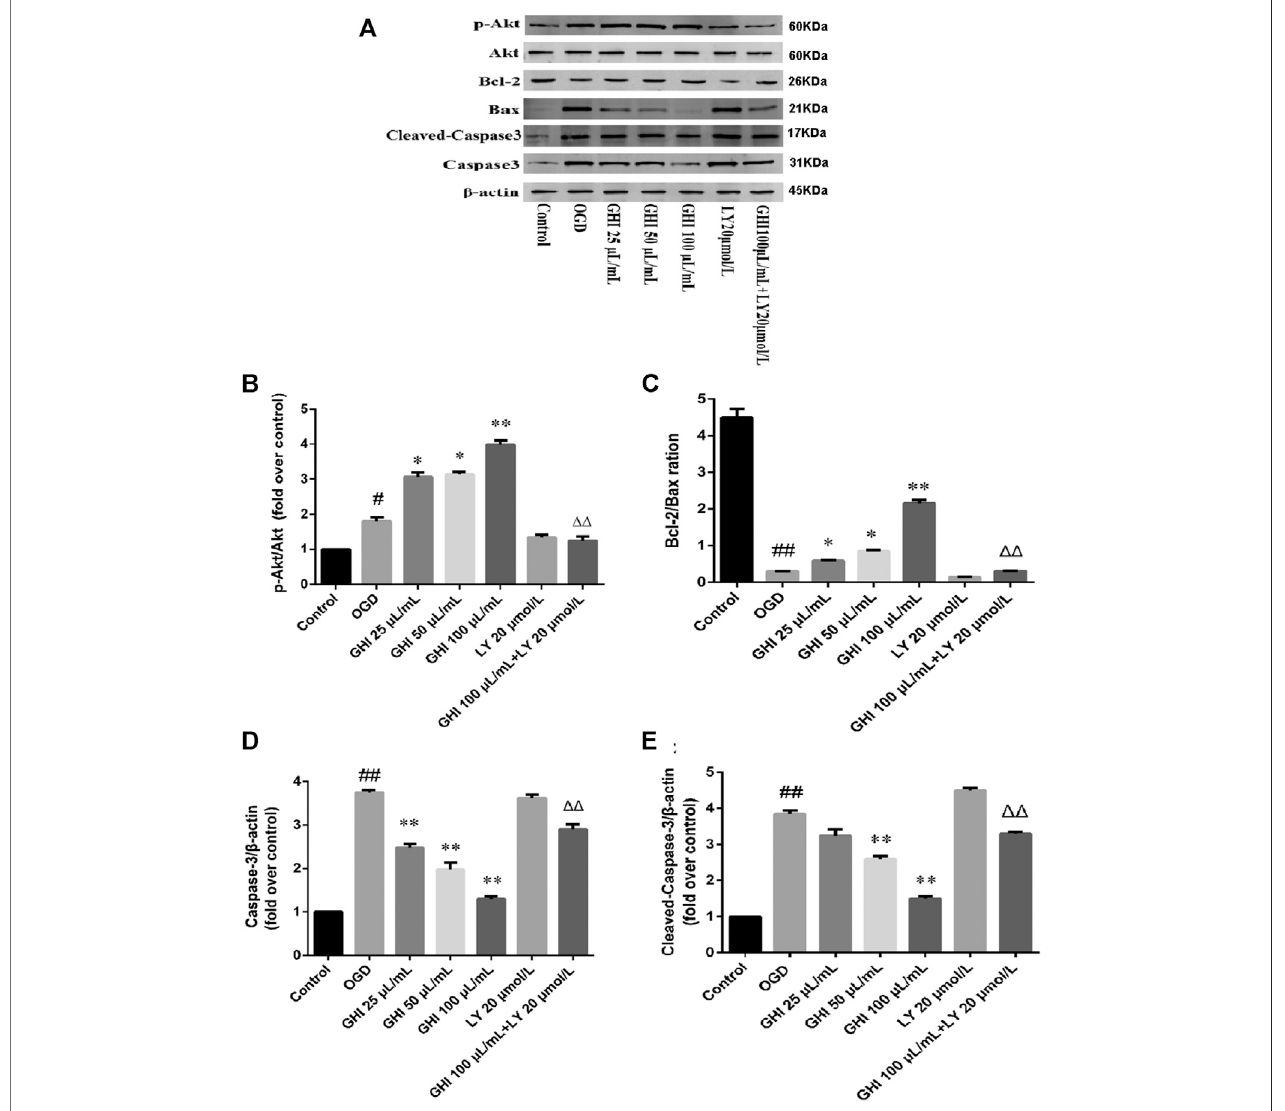
FIGURE15| GHIattenuatedOGD-inducedinjurybyregulatingthePI3K/Aktpathway. (A) RepresentativeimmunoblotsofAkt,p-Akt,Bax,Bcl-2,cleavedcaspase- 3,andcaspase-3proteins. (B) Theratioofp-Akt/Akt. (C) TheratioofBcl-2/Bax. (D) Thelevelsofcaspase-3. (E) Thelevelsofcleaved caspase-3.Dataareshownasthe mean ± SD(n (cid:2) 3). # p < 0.05, ## p < 0.01comparedwiththeControlgroup;* p < 0.05, ** p < 0.01comparedwiththeOGDgroup, Δ p < 0.05, ΔΔ p < 0.01comparedwiththe GHI 100 μ L/ml